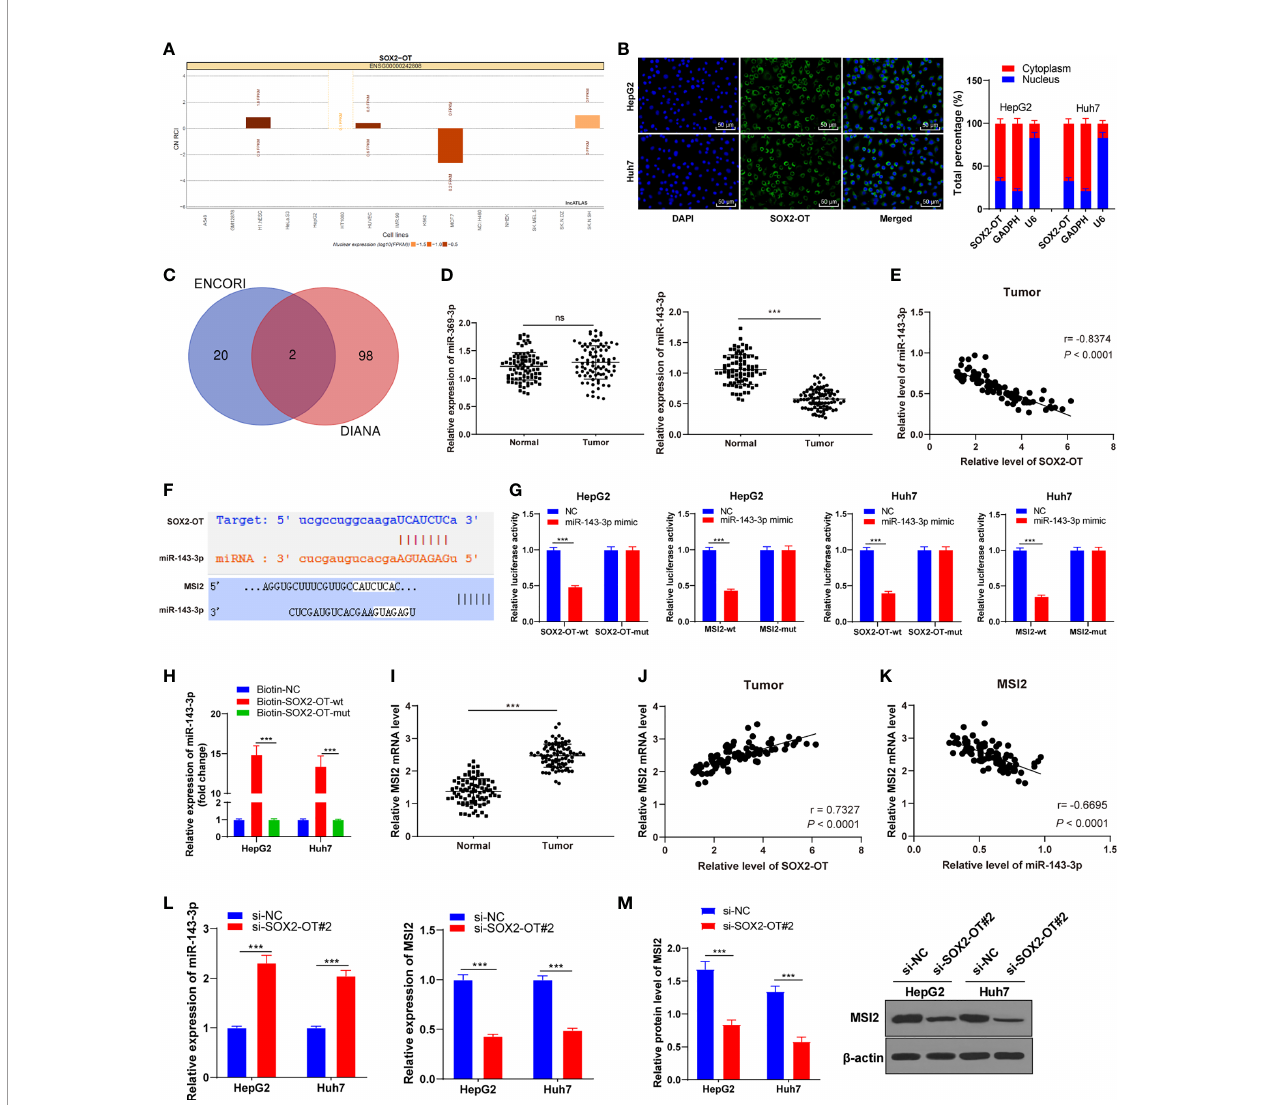
FIGURE 3 | SOX2-OT regulated MSI2 expression by binding to miR-143-3p. (A) A bioinformatics website (lncatlas.crg.eu) was used to predict, and the nuclear/ cytosol fractionation assay was used to verify the subcellular localization of SOX2-OT; (B) The distribution of SOX2-OT in nucleus and cytoplasm was detected by the RNA-FISH assay; (C) The downstream target genes of lncRNA SOX2-OT were predicted using ENCORI and DIANA Tool, and the intersection was obtained; (D) miR-369-3p and miR-143-3p levels in cancer tissues and adjacent normal tissues of HCC patients were detected by RT-qPCR, N = 87; (E) The correlation between SOX2-OT and miR-143-3p in cancer tissues and adjacent normal tissues of HCC patients was analyzed using Pearson coef fi cient; (F) The binding sites of SOX2-OT and miR-143-3p, and miR-143-3p and MIS2 were predicted using Targetscan and Starbase; (G) The target relationship of SOX2-OT and miR-143-3p, and miR-143-3p and MIS2 were veri fi ed by dual-luciferase assay; (H) The target relationship of SOX2-OT and miR-143-3p was detected by RNA Pull-down assay; (I) The mRNA level of MSI2 in cancer tissues and adjacent normal tissues of HCC patients was detected by RT-qPCR; (J) The correlation between SOX2-OT and MSI2 mRNA in cancer tissues of HCC patients was analyzed using Pearson coef fi cient; (K) The correlation between miR-143-3p and MSI2 mRNA in cancer tissues of HCC patients was analyzed using Pearson coef fi cient; (L) The expressions of miR-143-3p and MSI2 in HepG2 and Huh7 cells with si-SOX2-OT#2 were detected by RT-qPCR; (M) The protein level of MSI2 in HepG2 and Huh7 cells transfected with si-SOX2-OT#2 was determined by western blot. The cell experiment was repeated three times independently and data were all metrological data. All data were shown as mean ± standard deviation. One-way ANOVA was used for data analysis, followed by Tukey ’ s test. *** P < 0.001, ns (no statistical signi fi